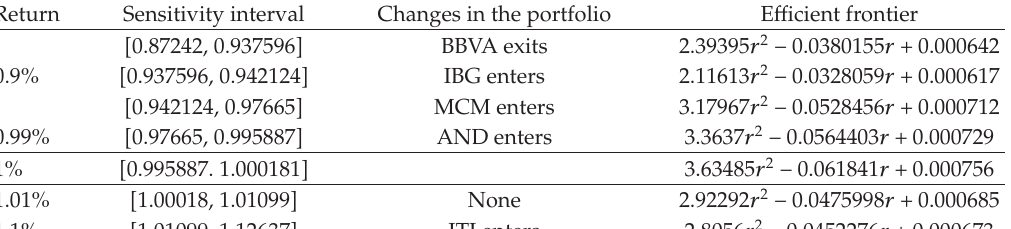
Table 6: Sensitivity analysis of an e ffi cient portfolio.